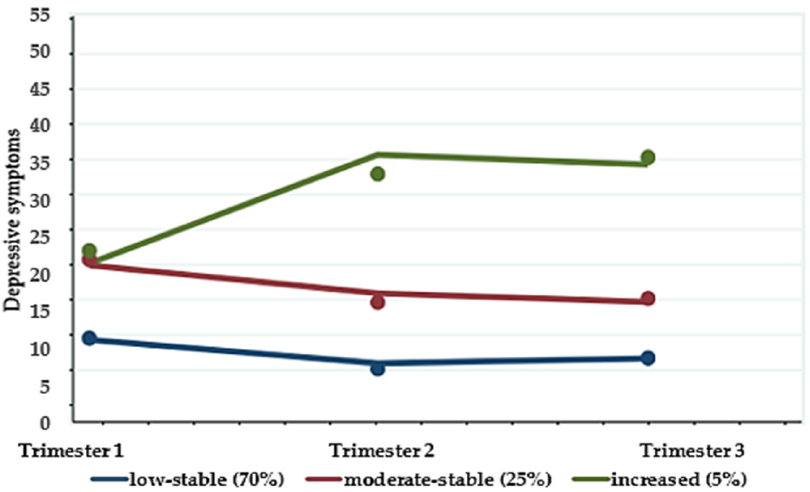
Figure 1. Trajectory groups for depression symptoms of pregnant women ( n = 136).